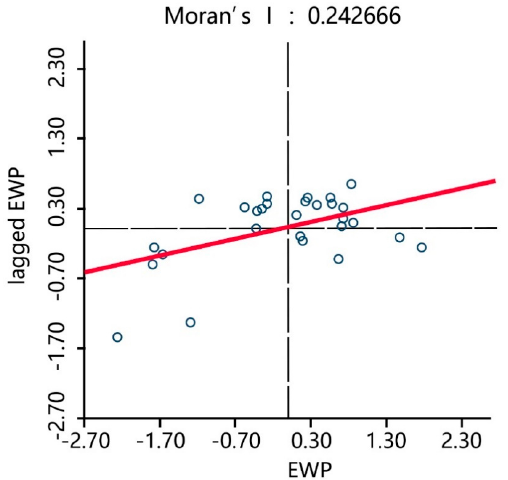
Figure 10. Moran ’s EWP scatterplots of the 30 provinces in 2017.